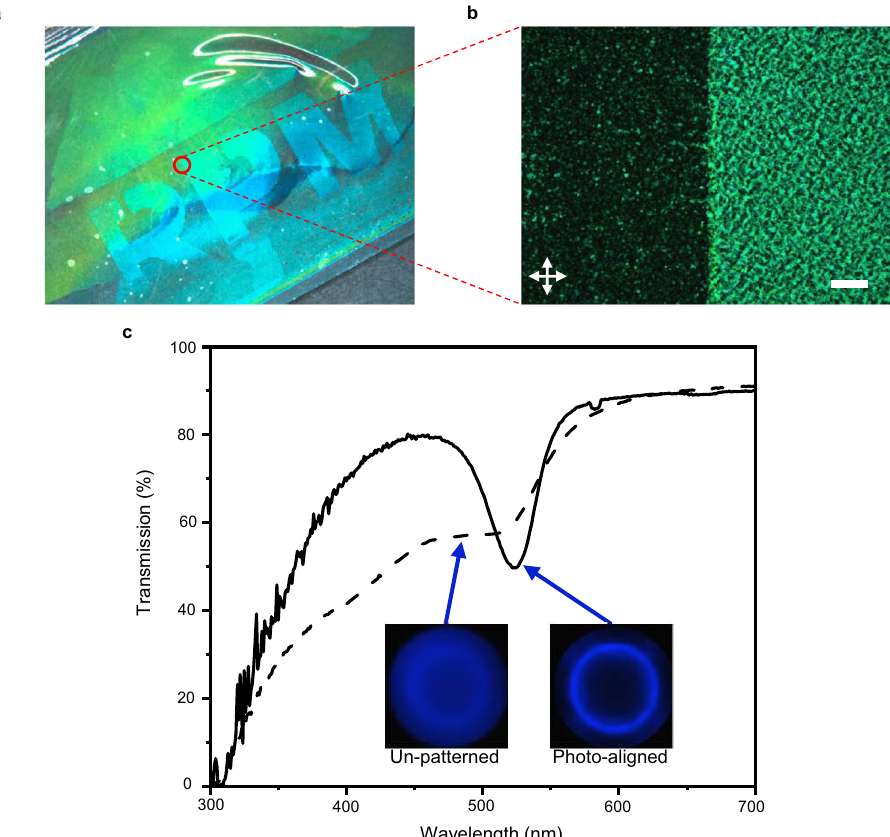
Fig. 5 Patternable lattice alignment. a Demonstration of photopatterned blue-phase I lattice alignment. To prepare, a photomask was employed to selectively irradiate the photoalignment cell with 445nm light. b Polarized optical micrograph texture imaged at the edge of the photopatterned region (scale bar 100 μ m). c Transmission spectra of BPI LCE unpatterned and photoaligned regions. Kossel diagrams qualitatively assess lattice homogeneity.